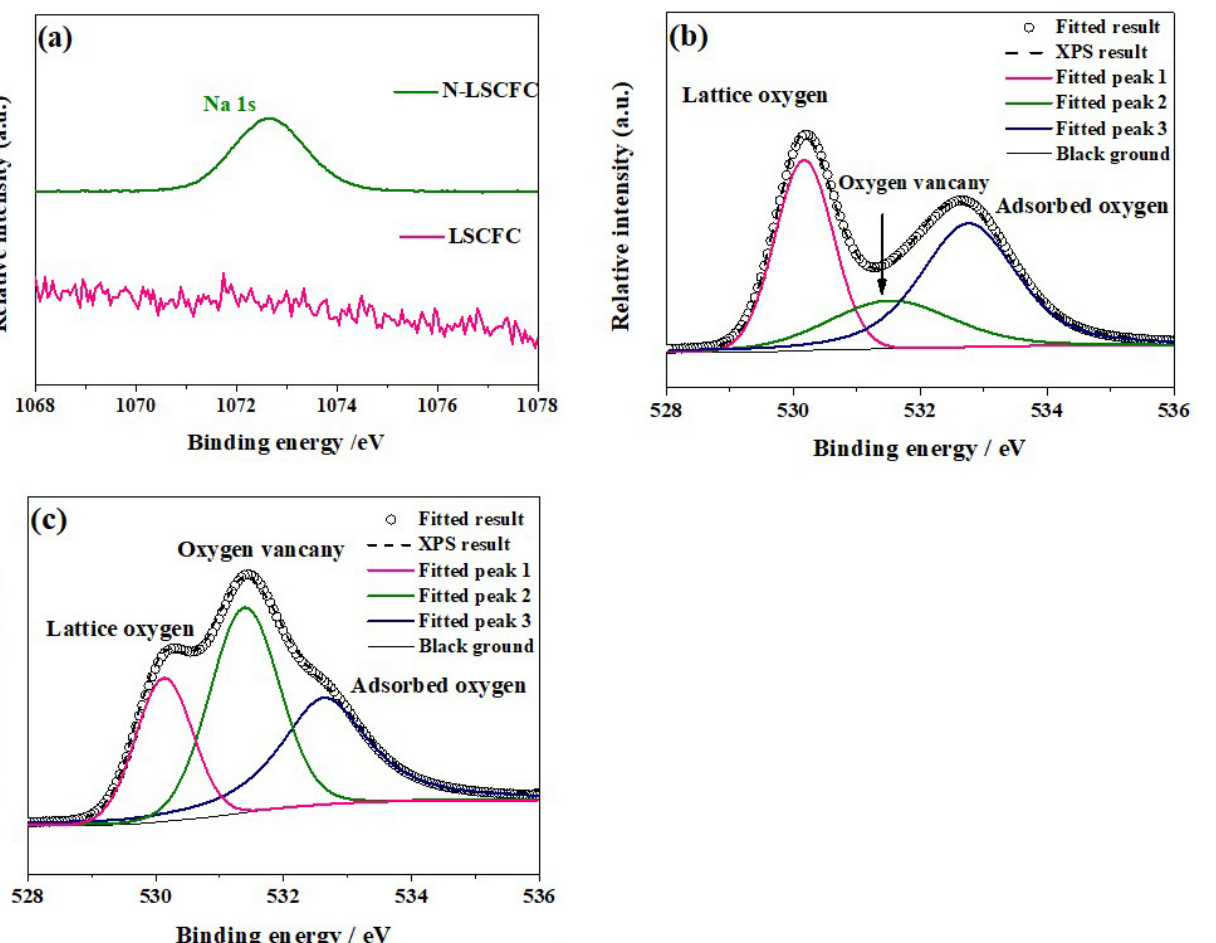
Figure 2. ( a ) XPS spectra of Na1s for LSCFC and N-LSCFC, and XPS spectra of O1s for ( b ) LSCFC and ( c ) N-LSCFC.